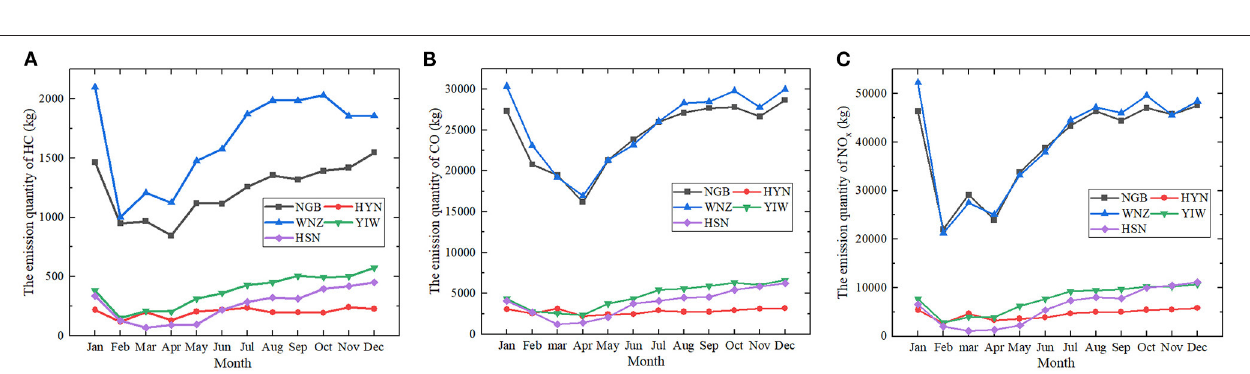
FIGURE 5 | The monthly variation of the air pollutants at 5 airports (except for HGH) in Zhejiang province, 2020. (A) The emission quantity of HC in kilograms (B) The emission quantity of CO in kilograms (C) The emission quantity of NO x in kilograms. NGB, Ningbo Lishe Airport; HYN, Taizhou Luqiao Airport; WNZ, Wenzhou Longwan Airport; YIW, Yiwu Airport; HSN, Zhoushan Putuoshan Airport.